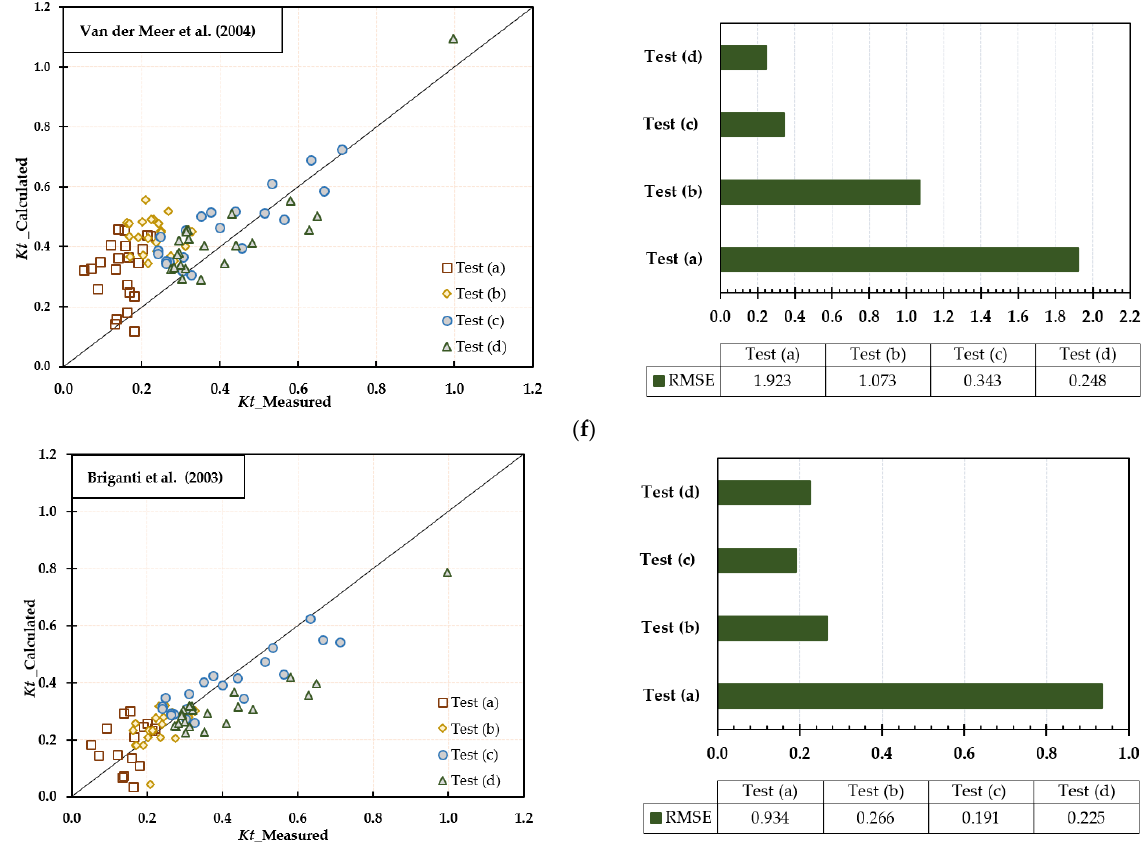
Figure 9. Comparison between K t -measured and K t -calculated with existing formulae: ( a ) Van der Meer [21]; ( b ) Van der Meer and Daemen [22]; ( c ) d’Angremond [23]; ( d ) Calabrese et al. [30]; ( e ) Seabrook and Hall [24]; ( f ) Van der Meer et al. [34]; and ( g ) Briganti et al. [33].